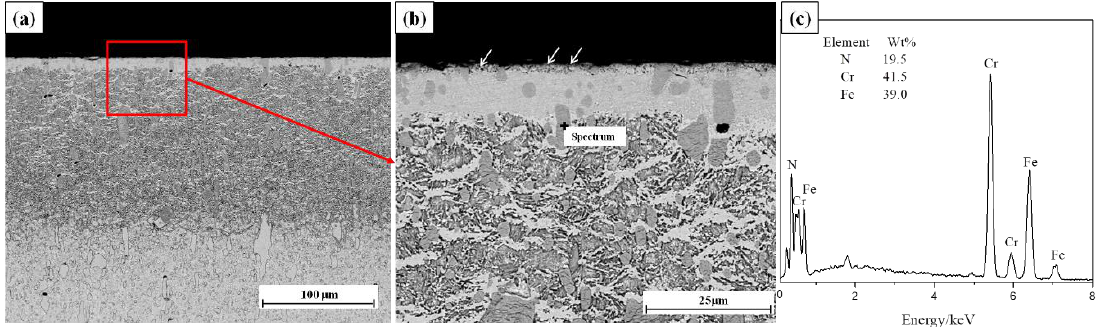
Figure 2. Cross-sectional microstructure of the nitrided layer: ( a ) overall features, ( b ) a close view of the rectangle in ( a ) and ( c ) energy dispersive spectroscopy (EDS) analysis of the point in ( b ).